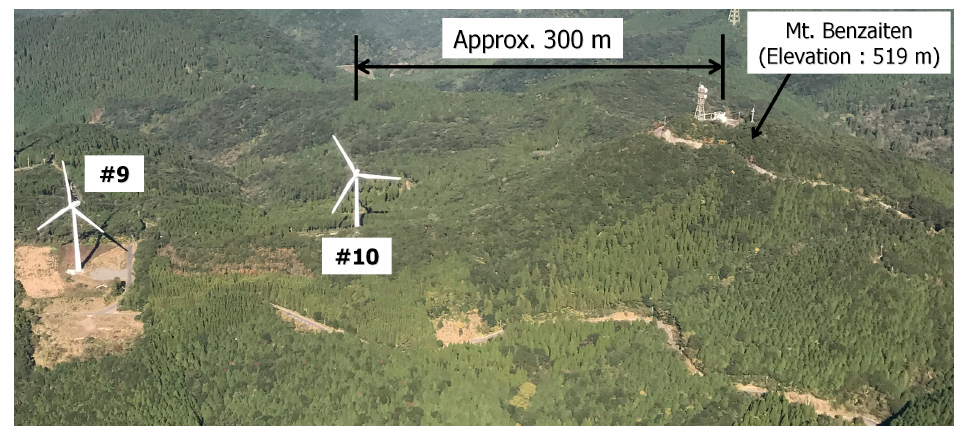
Figure 3. Relative locations of Mt. Benzaiten (elevation 519 m) and wind turbine #10. Table 1. Elevation information for wind turbine #10 and distance between Mt. Benzaiten (elevation 519 m) and wind turbine #10.